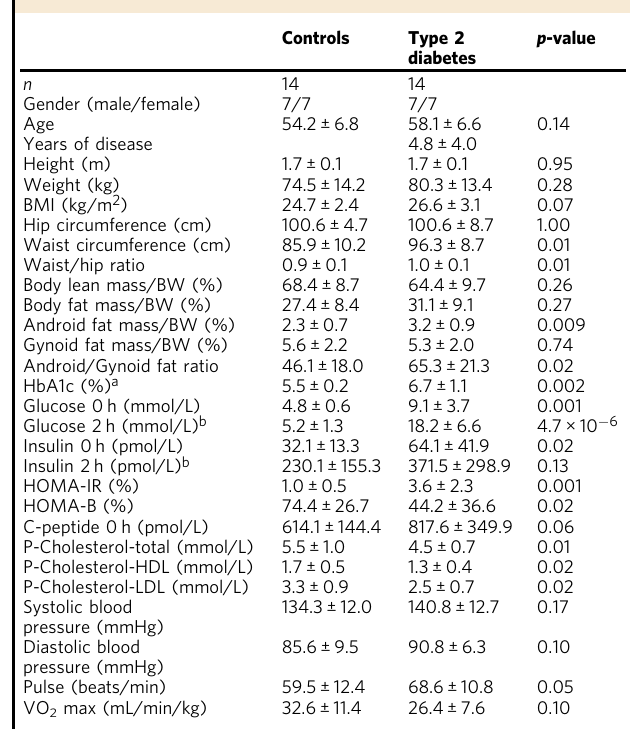
Table 1 Clinical characteristics of human donors of muscle